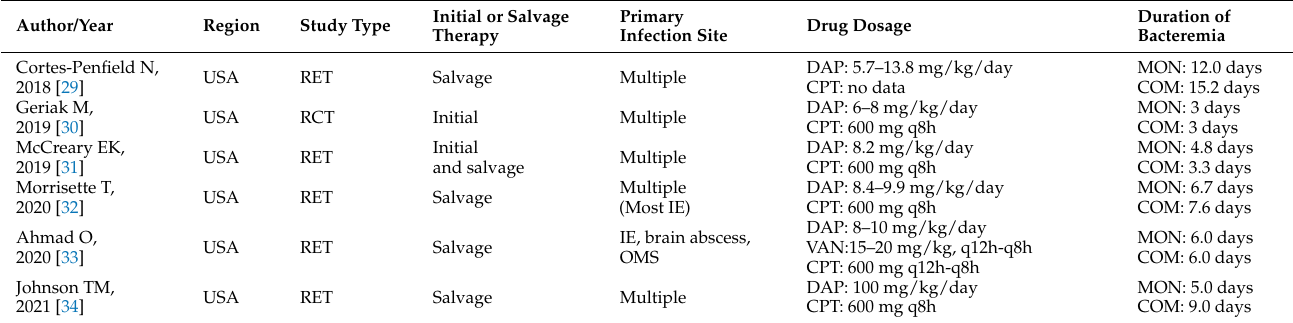
Table 1. Characteristics of the included